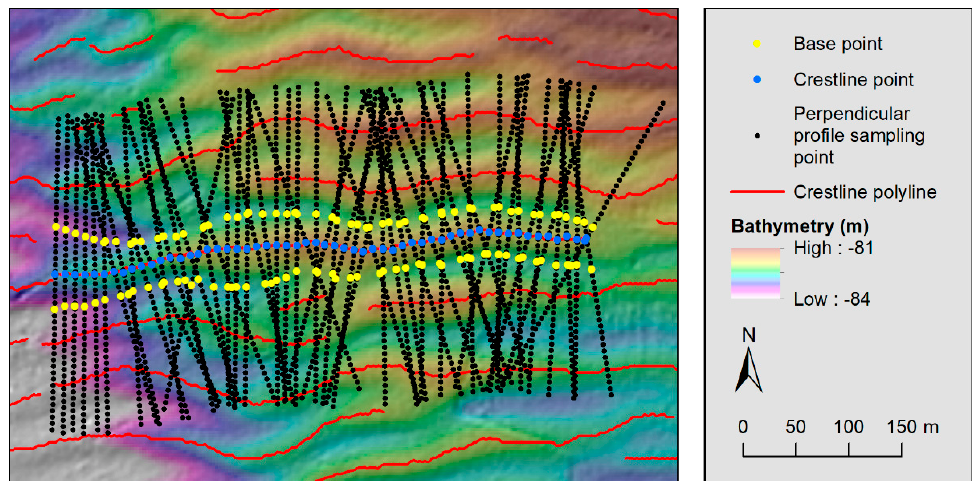
Figure 6. Illustration of the process used to calculate metrics. Perpendicular cross-sections are generated along each crestline polyline and are used to refine the position of the bedform crestline and bases XYZ coordinates that are in turn used to calculate metrics.